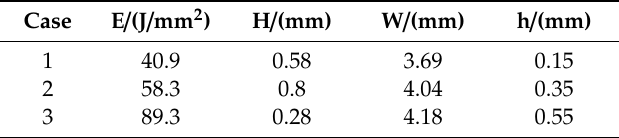
Figure 4. Transverse section of the high entropy alloy laser cladding layer under different specific energies. ( a ) 40.9 J / mm 2 ; ( b ) 58.3 J / mm 2 ; ( c ) 89.3 J / mm 2 . Table 3. The size of the cladding layer under di ff erent specific energy.